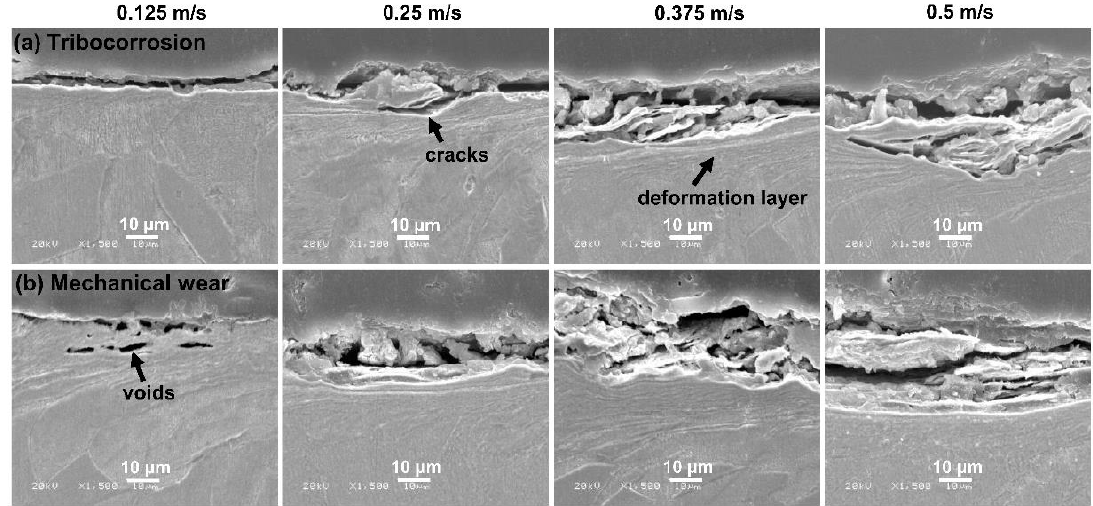
Figure 6. The cross-section morphologies of Monel 400 alloy in conditions of ( a ) tribo-corrosion and ( b ) mechanical wear under different rotational velocities of 0.125 m/s, 0.25 m/s, 0.375 m/s and 0.5 m/s in seawater.